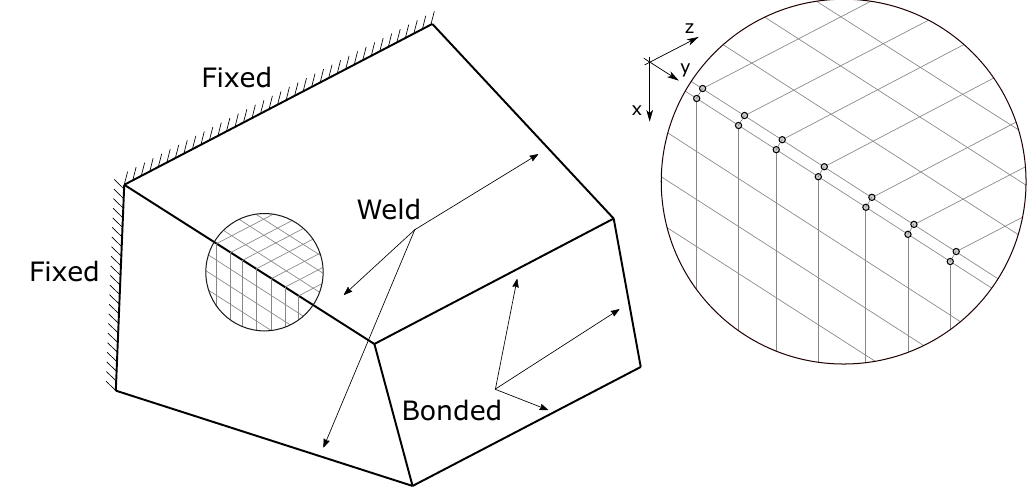
Figure 5. Boundary conditions and detail of the welding.